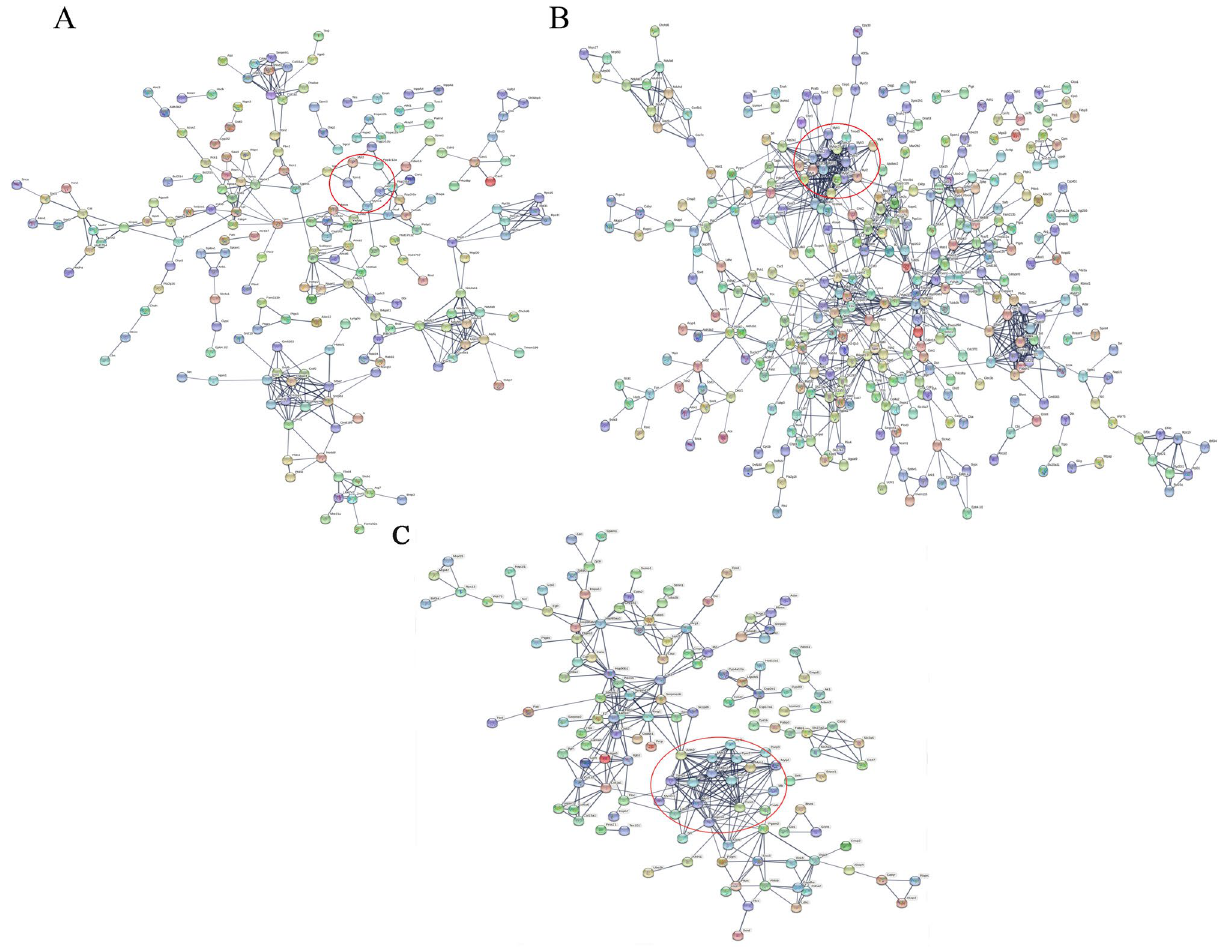
Figure 7. Protein–protein interaction network of differentially expressed proteins in the (A) WF/WC, (B) WS/ WF and (C) WS/WC groups. Red circle represents the interaction network between tropomyosin 1 (TPM1), myosin light chain 2 (MYL2) and myosin heavy chain 11 (MYH11).